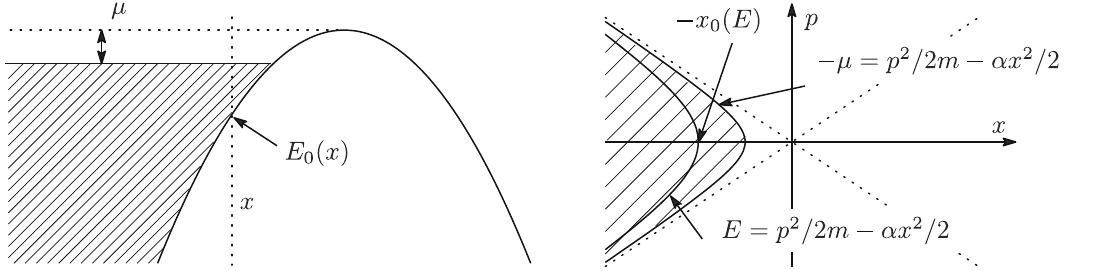
Fig. 1 The sketch of the fermions in the inverse harmonic potential which corresponds to the bosonic non-critical string theory. − μ is the fermi energy. (RIGHT) The configuration of the fermions in the phase space. The region occupied by the fermions is called